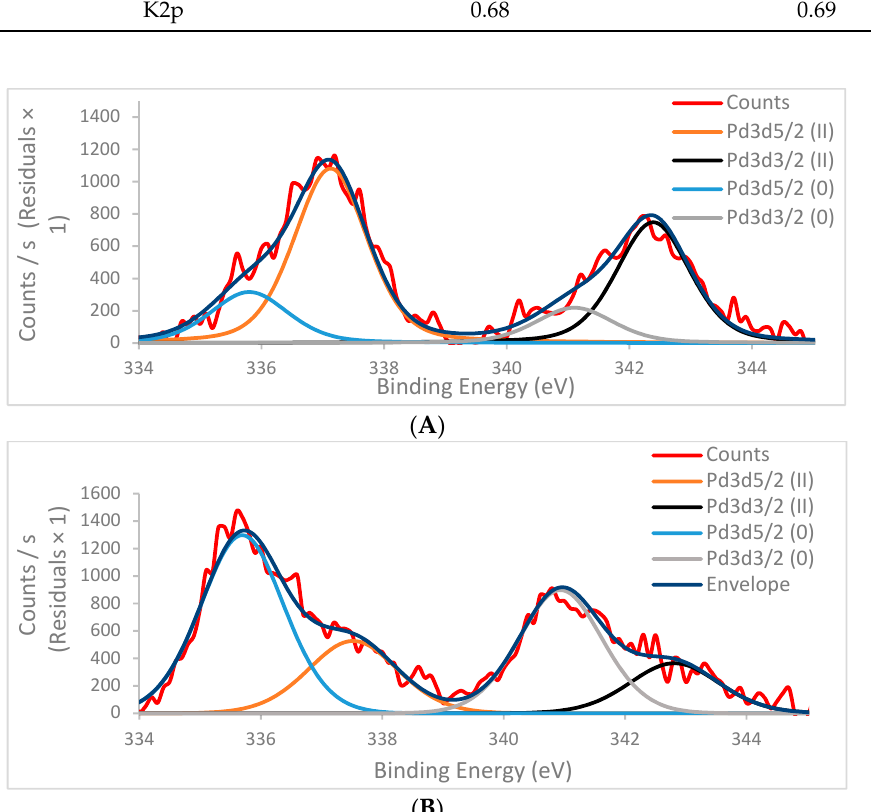
Figure 3. XPS spectra of i -Pd(OAc) 2 (TPPTS) 2 in the Pd3d region ( A ) Before reaction, ( B ) After 24 h of reaction.